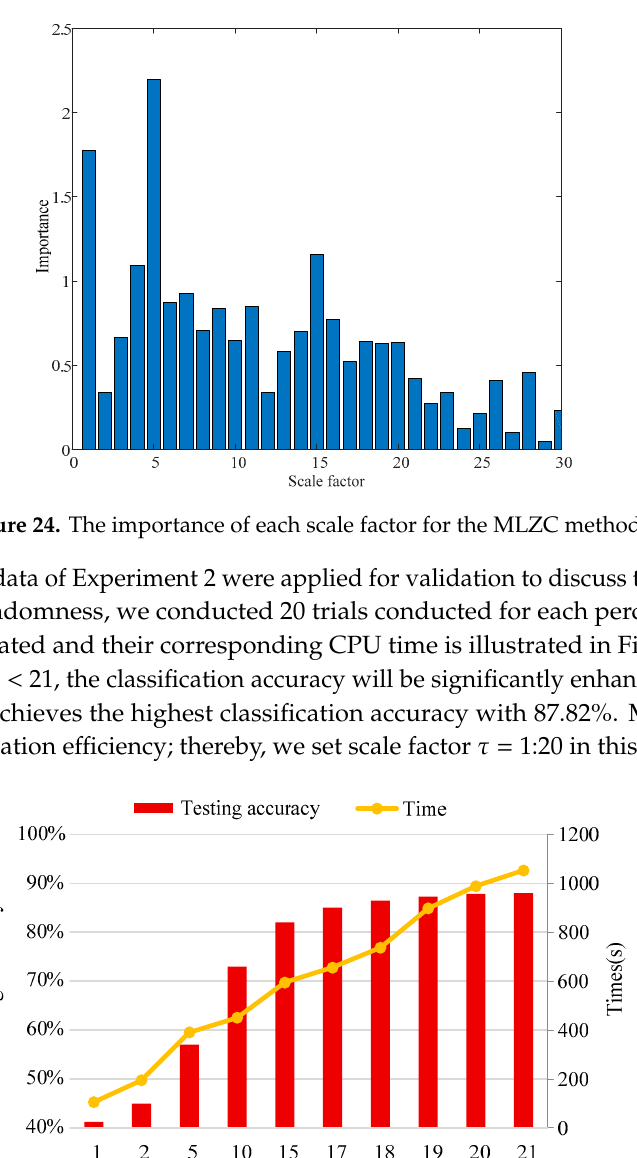
Figure 23. The importance of each component for the HLZC method.